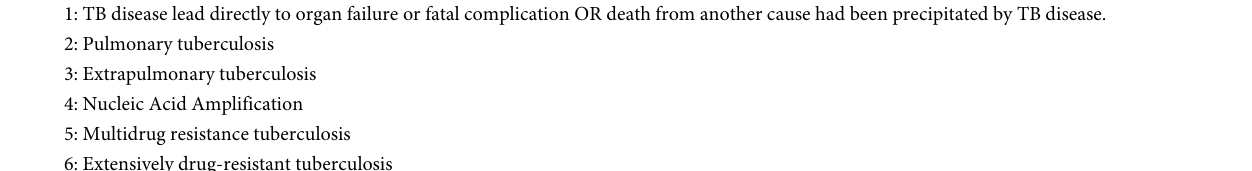
death. The proportion of patients diagnosed postmortem did not change significantly during the study period.